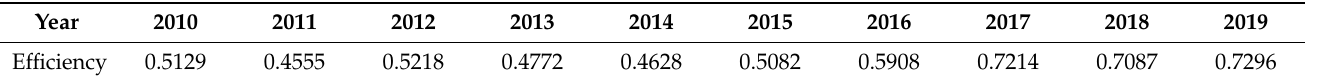
Table 4. Annual average values of green innovation efficiency in resource-based cities.